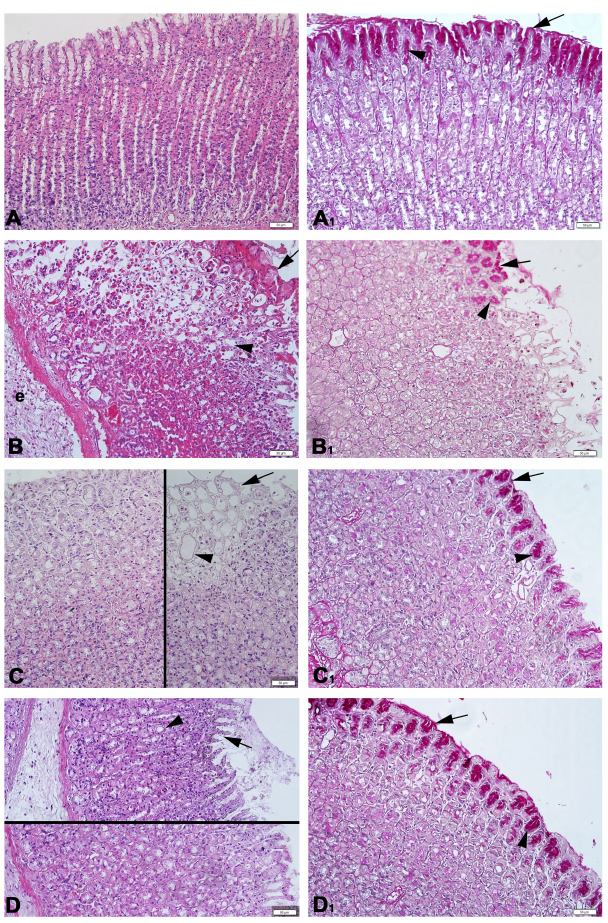
Figure 3. Representative micrographs illustrating the Figure 2. Representative micrographs illustrating the histological histological appearances of gastric samples from the appearances of gastric samples from the ethanol groups. indomethacin groups. Micrographs A, B, C, D depict H&E staining; Micrographs A, B, C, and D depict H&E staining and A1, B1, C1, D1 A1, B1, C1, D1 depict PAS staining. Indo control group (A, A1) depict PAS staining. Ethanol control group (A, A1) revealed a revealed a regular gastric surface epithelium and glandular cells regular gastric surface epithelium and glandular cells with PAS- with PAS-positive surface mucous cells (arrow) and neck mucous positive surface mucous cells (arrow) and neck mucous cells cells (arrowhead). In indo ulcer group (B, B1), there was severe (arrowhead). In ethanol ulcer group (B, B1), there was severe degeneration in both surface cells (arrow) and glandular epithelial degeneration in both surface cells (arrow) and glandular epithelial cells (arrow) with inflammatory cell infiltration (e). There was a cells (arrow) with inflammatory cell infiltration (e). PAS-positive significant decrease in PAS-positive surface mucous cells (arrow) surface mucous cells (arrow) and neck mucous cells (arrowhead) and neck mucous cells (arrowhead). RTN-indo ulcer group (C, C1) were markedly decreased. RTN-ethanol ulcer group (C, C1) revealed partly preserved surface epithelium (arrow) and glandular revealed surface epithelium (arrow) and glandular epithelium epithelium (arrowhead) with a moderate improvement in PAS- (arrowhead) with moderate degeneration and a moderate increase positive surface mucous (arrow) and neck mucous cells in PAS-positive surface mucous (arrow) and neck mucous cells (arrowhead). MET-indo ulcer group (D, D1) was comparable to (arrowhead). MET-ethanol ulcer group (D, D1) was comparable to RTN-ethanol ulcer group in terms of morphology with more RTN-ethanol ulcer group in terms of morphology but there was increase in PAS-positive surface mucous cells (arrow) and neck markedly increased PAS-positive surface mucous cells (arrow) and mucous cells (arrowhead). Scale: 50 µm. Original neck mucous cells (arrowhead). Scale: 50 µm. Original magnification: 10 magnification 10 × .